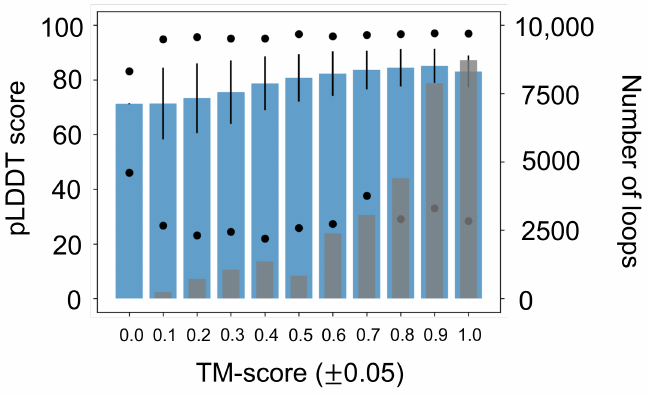
Figure 7. pLDDT score as a function of TM-score (blue) with standard error bars and mini- mum/maximum pLDDT scores. As TM-score score increases, the average pLDDT score increases. Gray bars represent the number of loops in each TM-score range. Most loops (16,596 or 52.4%) have a TM-score between 0.85 and